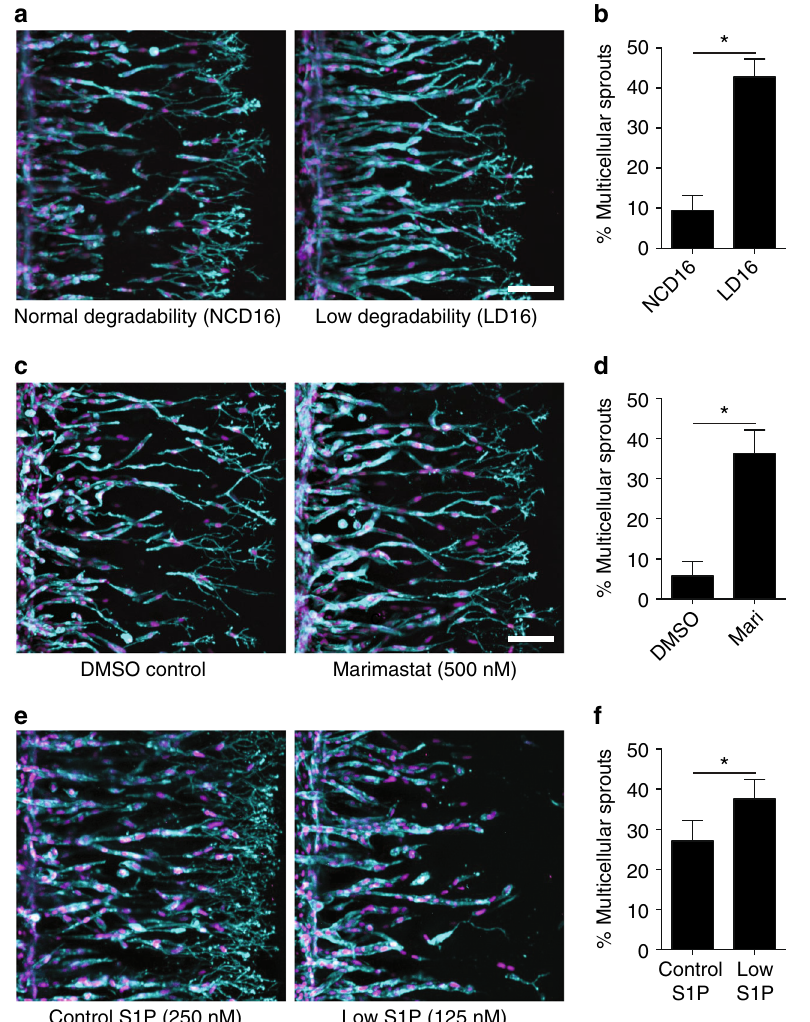
Fig. 5 Matrix degradability controls angiogenic sprout multicellularity. a HUVECs invading into DexMA gels crosslinked with NCD and LD peptide sequences. Crosslinker concentration was kept constant at 16 mM to ensure comparable gel stiffness (1000 Pa). b Sprout multicellularity of DexMA gels crosslinked with NCD and LD sequence. c HUVECs invading into soft (16 mM NCD crosslinker) DexMA gels in the presence of a broad spectrum MMP inhibitor, Marimastat, or DMSO carrier only. d Sprout multicellularity with and without Marimastat treatment. e HUVECs invading into intermediate (26 mM NCD crosslinker) DexMA gels with varying S1P concentration. f Sprout multicellularity as a function of S1P concentration. a , c , and e contain composite fl uorescence images showing F-actin ( cyan ) and nuclei ( magenta ) ( scale bar , 100 μ m). The % of sprouts possessing six or more nuclei was used as a metric for sprout multicellularity in ( b , d , f ), and all data are presented as a mean ± s.d. and signi fi cance was determined from a * P <